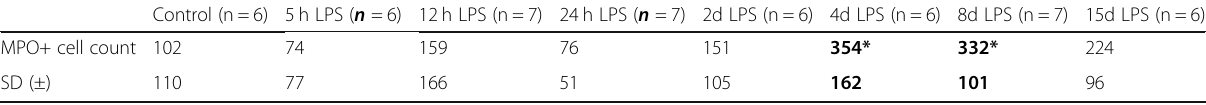
Table 2 Immune cells count in the mucosal layer